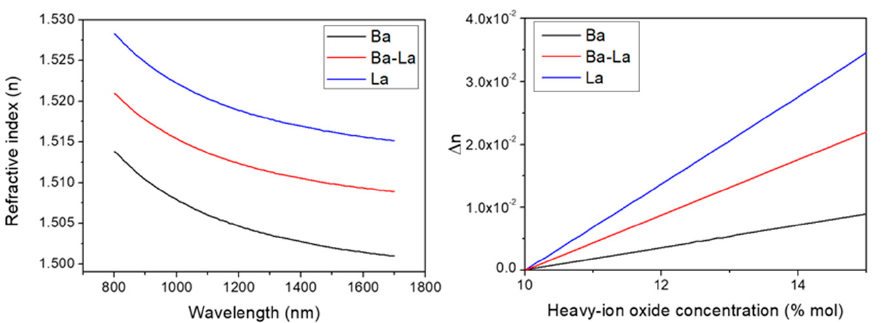
Figure 1. Spectral dependence of the refractive index of the glass samples measured by spectroscopic ellipsometry ( a ). Index change as a function of the heavy-ion concentration estimated by the electronic polarizability method ( b ). Table 3. Polarizabilities of ions used for local index calculations in the samples upon